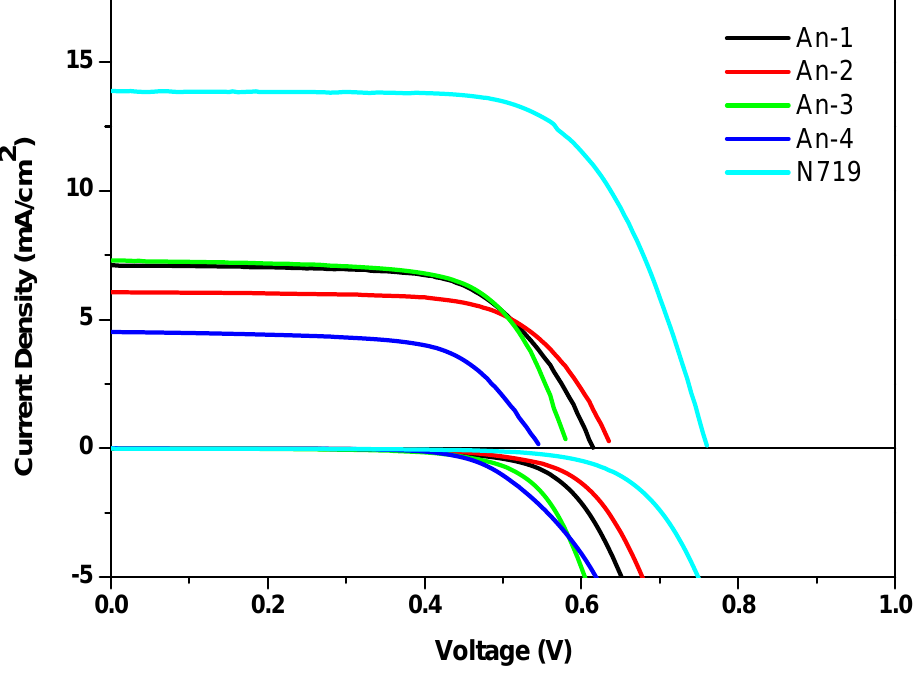
Figure 5. The current density-voltage curves and dark current of DSSCs based on the dyes.